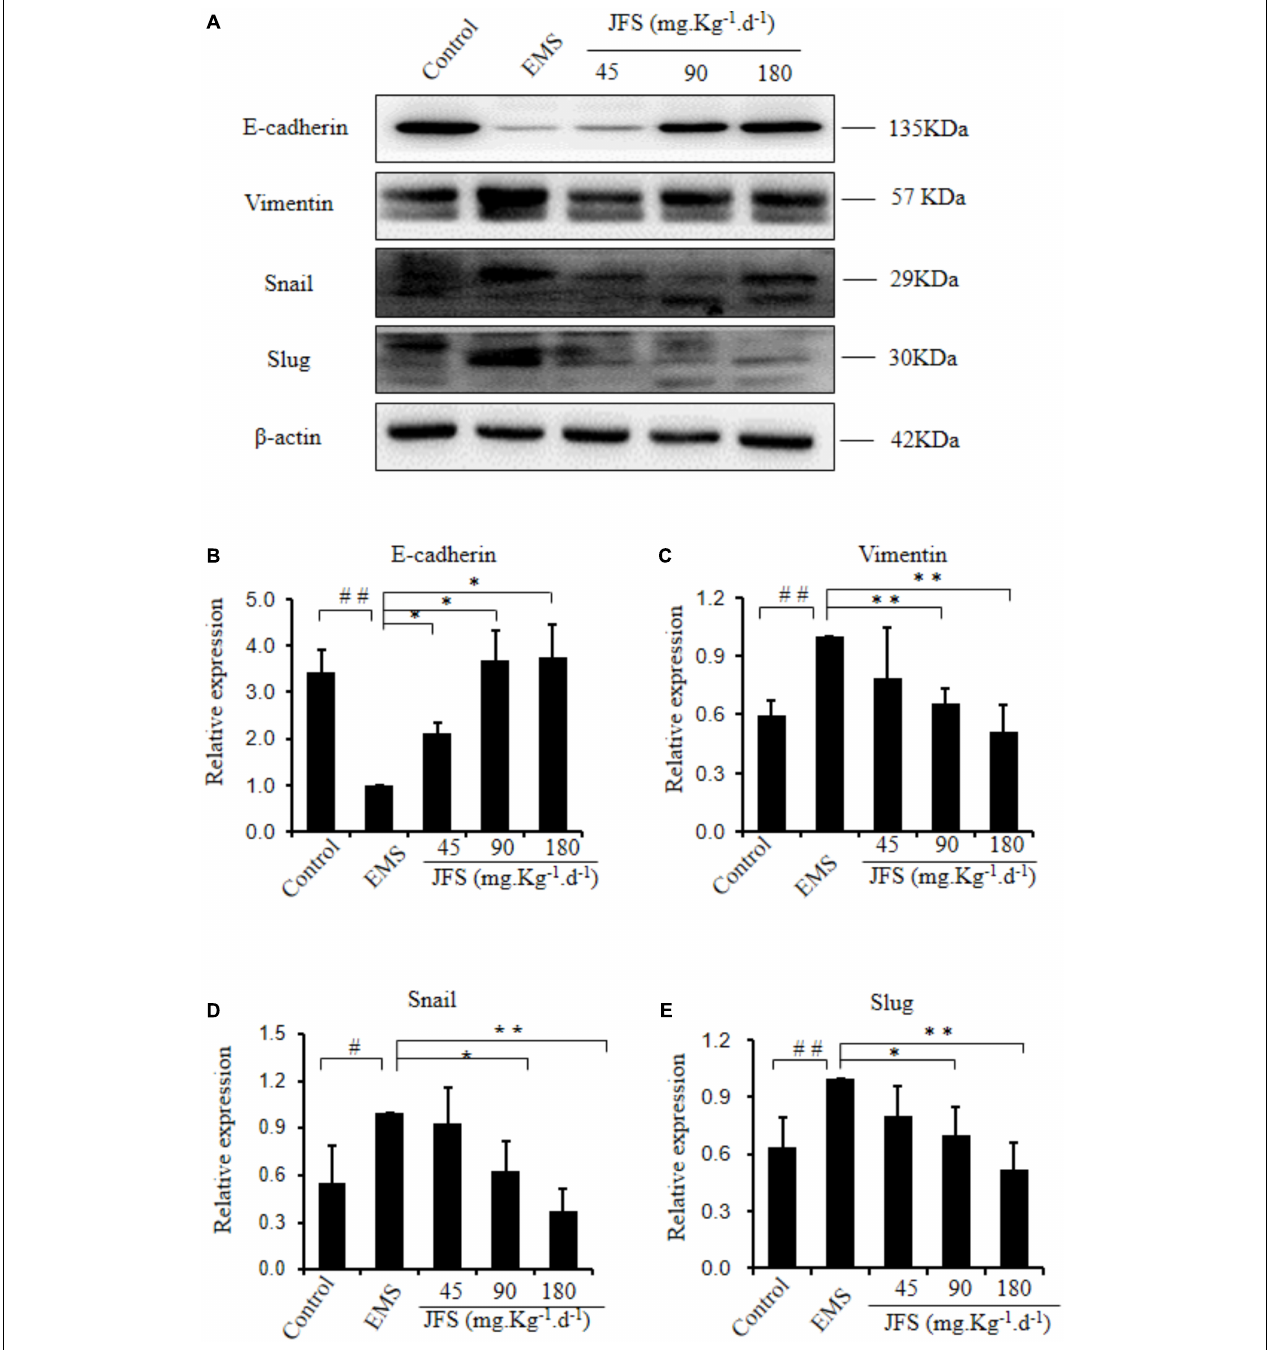
FIGURE 8 | Modification of epithelial–mesenchymal transition protein treating with JFS. (A–E) The protein levels of E-cadherin, Vimentin, Snail, and Slug were detected by western blotting, and the ratio of E-cadherin, Vimentin, Snail, and Slug with β -actin were shown. # P < 0.05 to control, ## P < 0.01 to control, ∗ P < 0.05 to EMS, ∗∗ P < 0.01 to EMS. Columns, mean ( n = 3). Bars, SD. EMS, endometriosis; JFS, Jiawei Foshou San